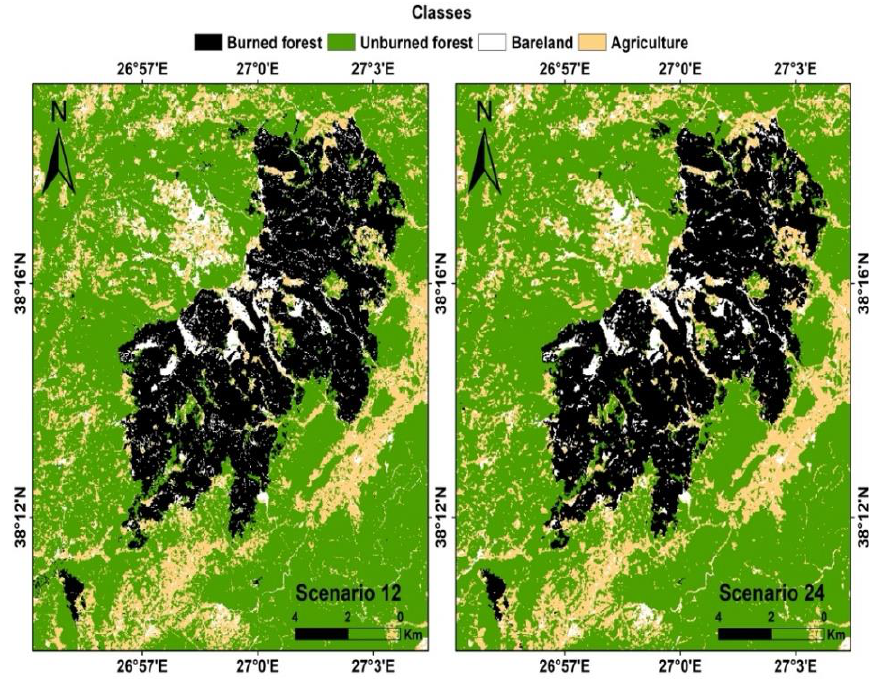
Figure 5. The highest classification accuracy results of scenarios using Sentinel-2 (S12) and Landsat-8 (S24).